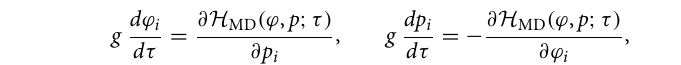
Figure 3. Trajectories of all flux variables { ϕ i } (δτ) − 1 = 50,000